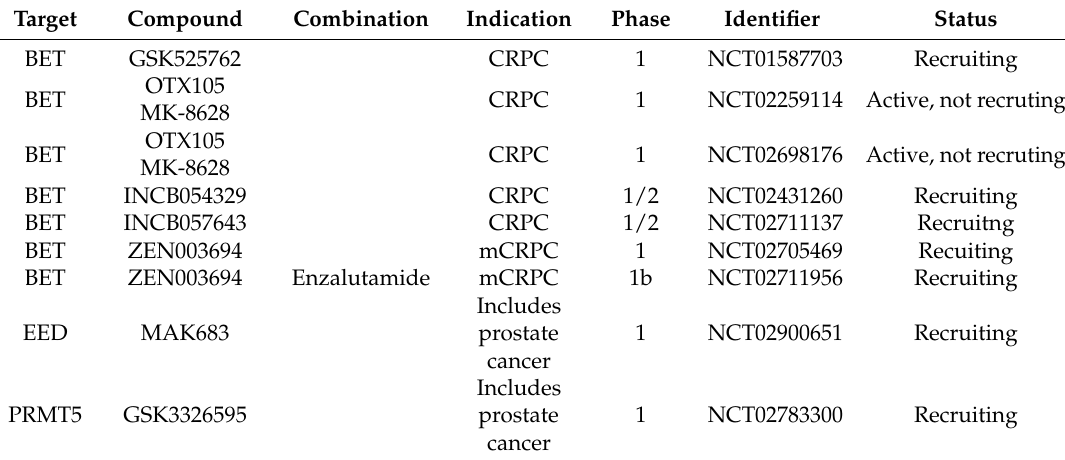
Table 2. Clinical studies in prostate cancer with drugs addressing the novel epigenetic targets bromodomain and extra-terminal protein (BET), embryonic ectoderm development protein (EED) and protein arginine methyltransferase 5 (PRMT5). Source: